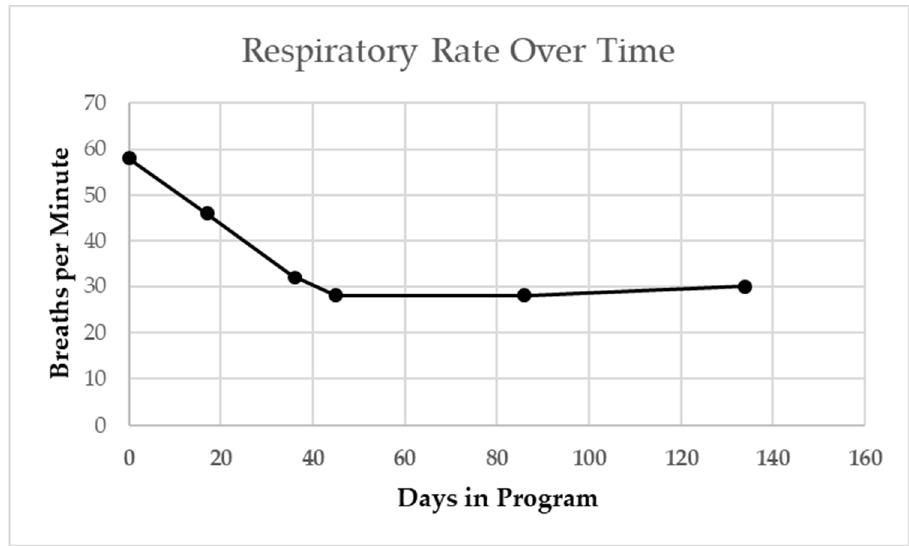
Figure 4. Patient’s resting respiratory rate at primary care and pulmonologist visits. Steady decline from start of activity-based therapy intervention overtime, including when sick with viral cold. Winter season indicated by gray shading. Dashed line indicates age-based median norm.